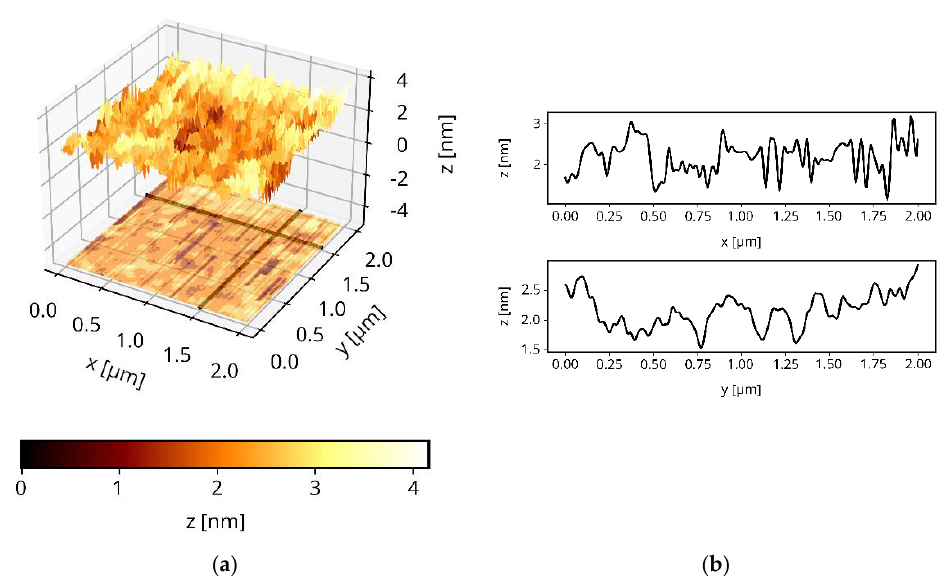
Figure 10. AFM surface topography images of the SiO 2 thin film deposited at 200 °C ( a ) and profiles in two cross-sections ( b ).